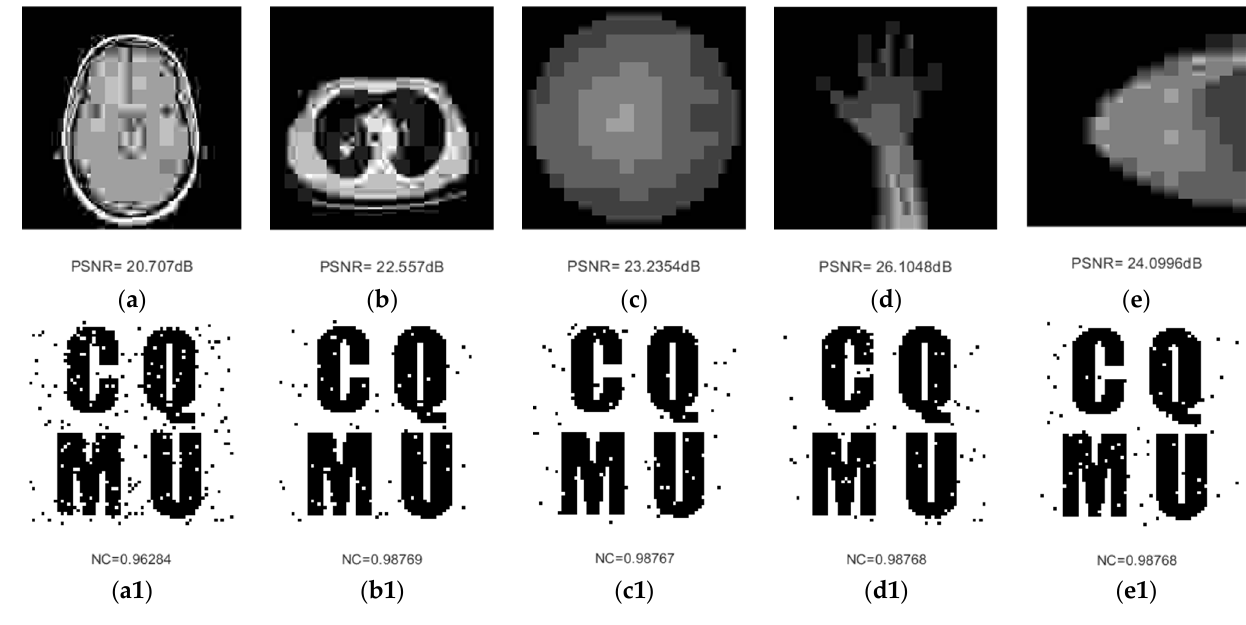
10 of 20 Figure 9. Attacked medical images and restored watermarking images under Gaussian noise 30%: ( a , a1 ) brain and extracted watermarking image; ( b , b1 ) chest and extracted watermarking image; ( c , c1 ) fundus blood vessels and extracted watermarking image; ( d , d1 ) hand and extracted water- marking image; and ( e , e1 ) breast and extracted watermarking image. Table 1. The result under Gaussian noise attacks. Name